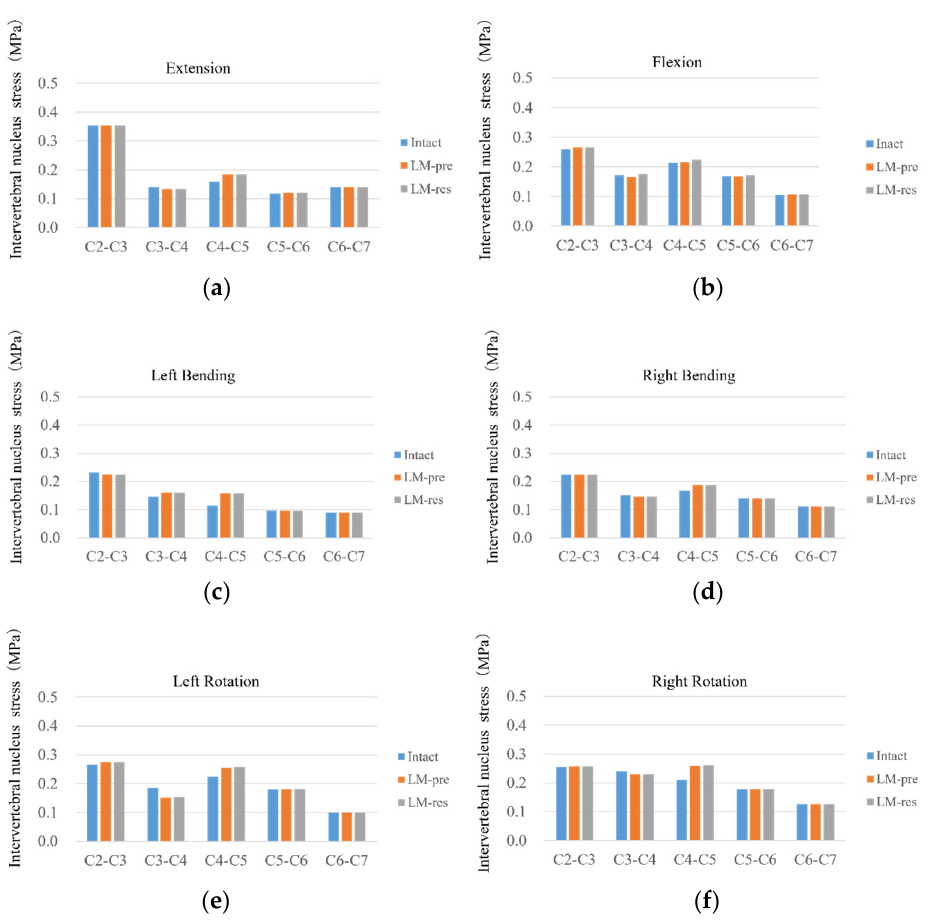
Figure 7. Intervertebral nucleus stress in ( a ) extension, ( b ) flexion, ( c ) left bending, ( d ) right bending, ( e ) left rotation, and ( f ) right rotation. The vertical axis is stress (MPa), the horizontal axis is each intervertebral level.